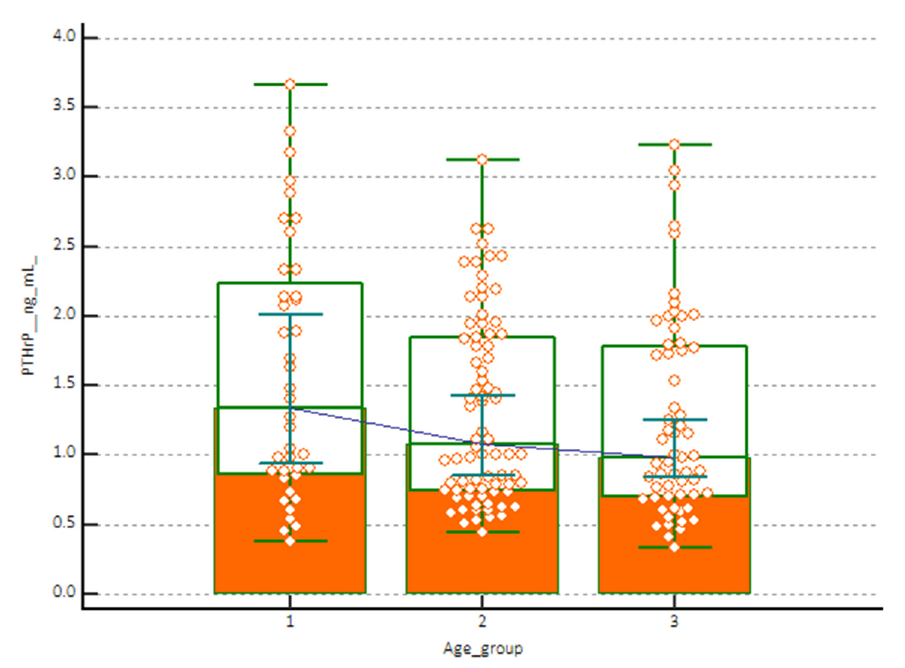
Figure 4. Plot scatter diagram of the measurements versus age. The calculated mean (central line) and centile curves.